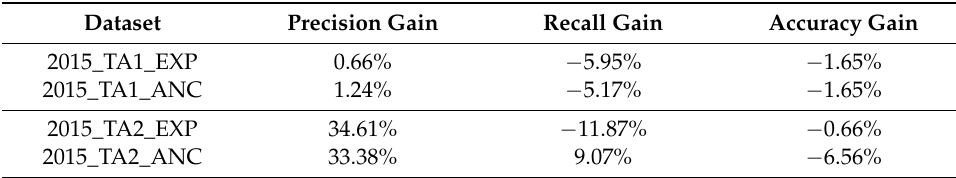
Table 6. Changes in performance indicators using the highest and the lowest agreement in the reference